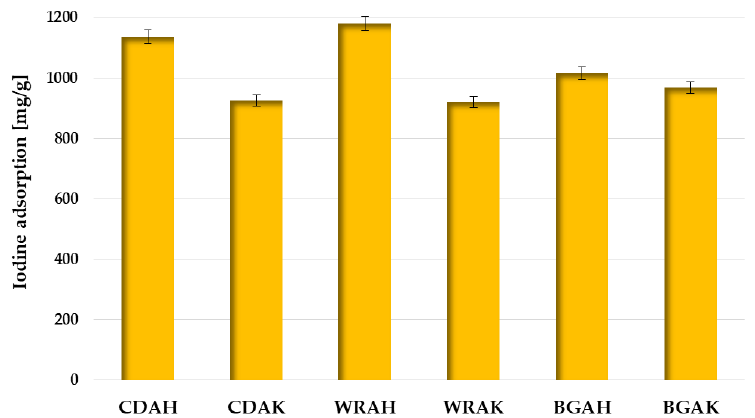
Figure 6. Iodine adsorption by the activated carbons prepared from waste food products.